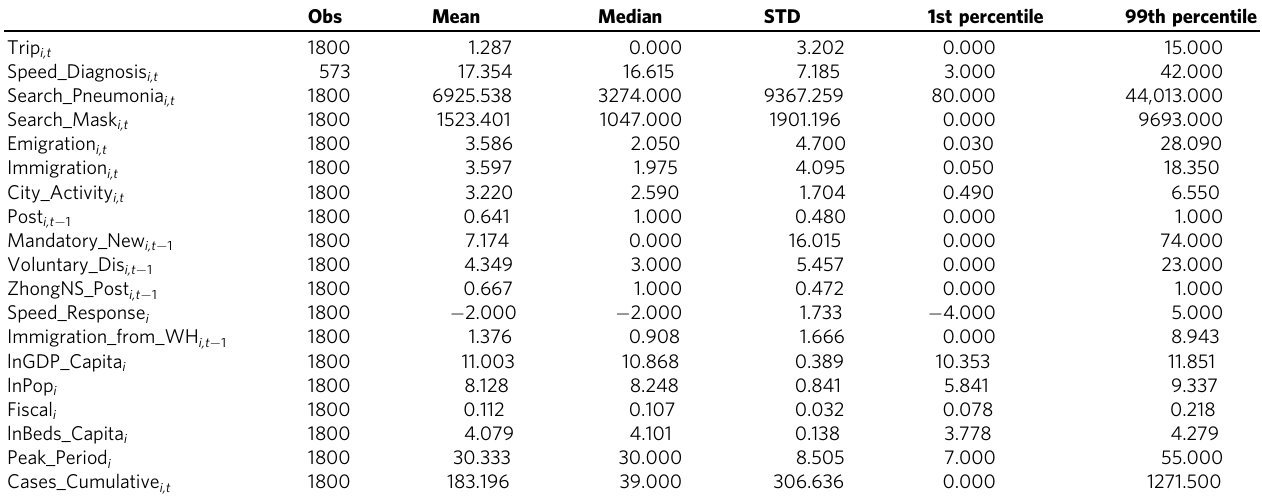
Table 1 Descriptive statistics of main